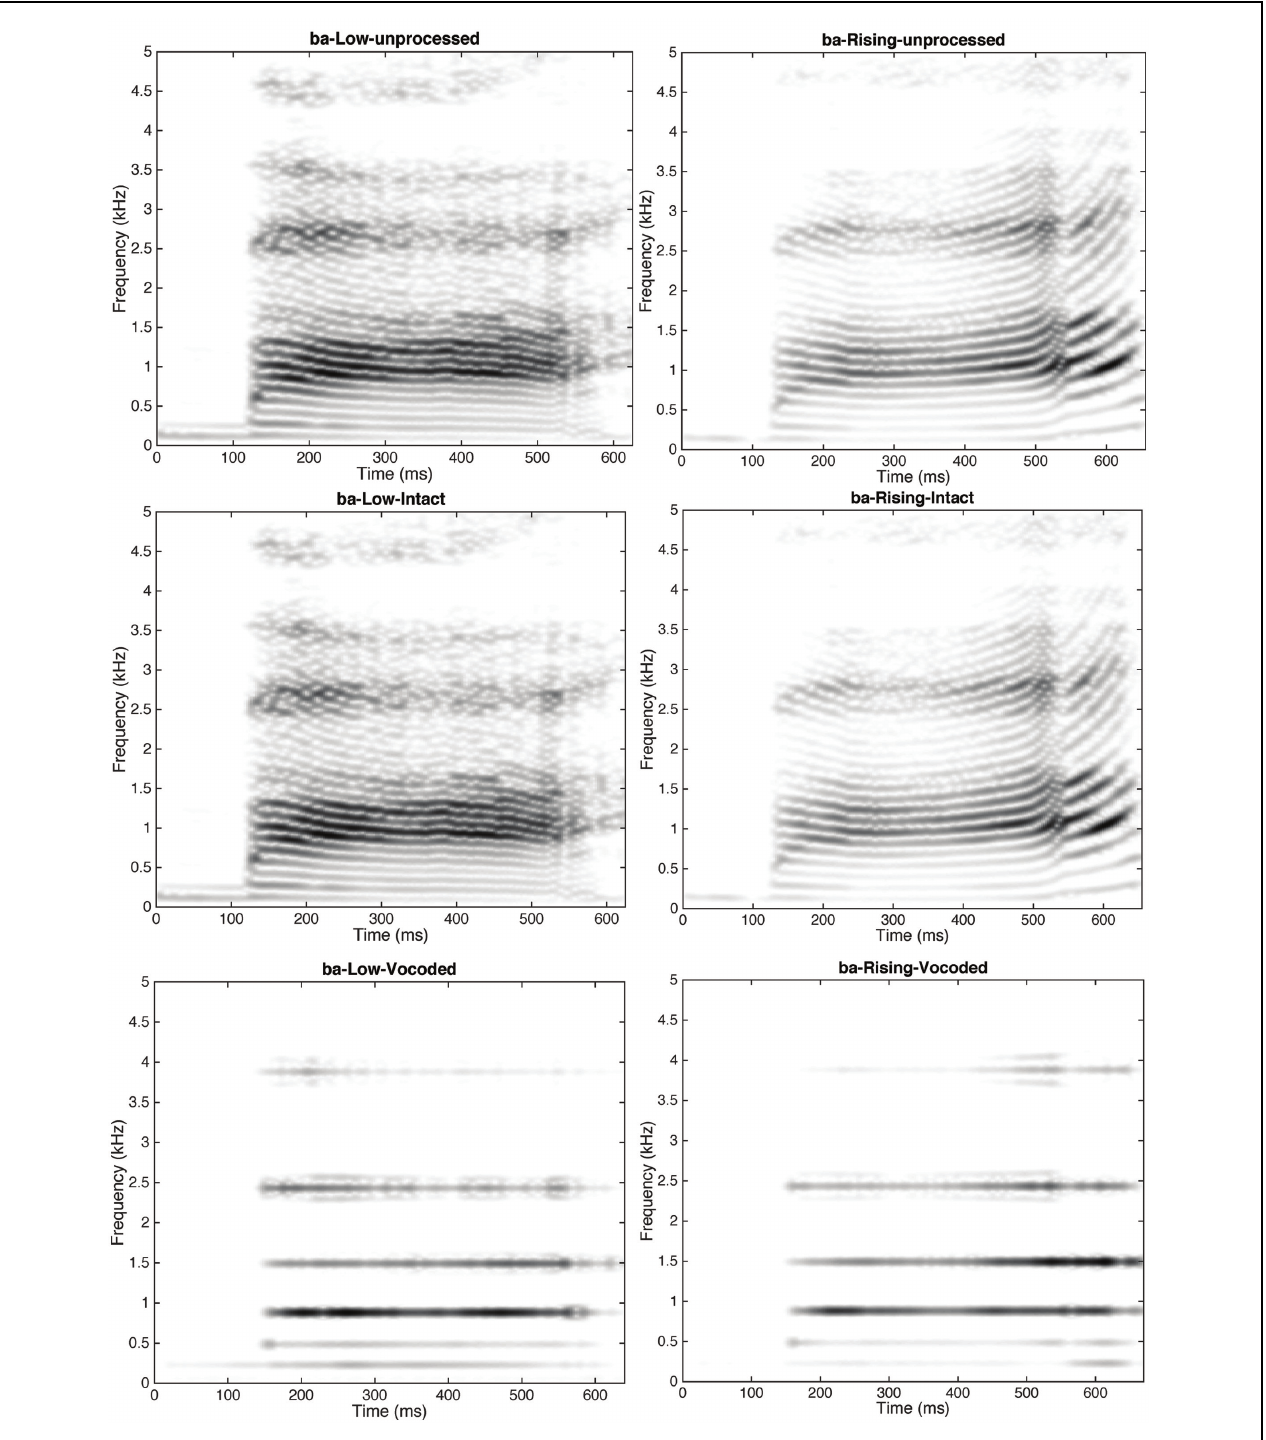
FIGURE 2 | Spectrograms of /ba/ rising (left) and /ba/ low (right) stimuli in the Original (top), Intact (middle) and Vocoded (bottom) conditions.